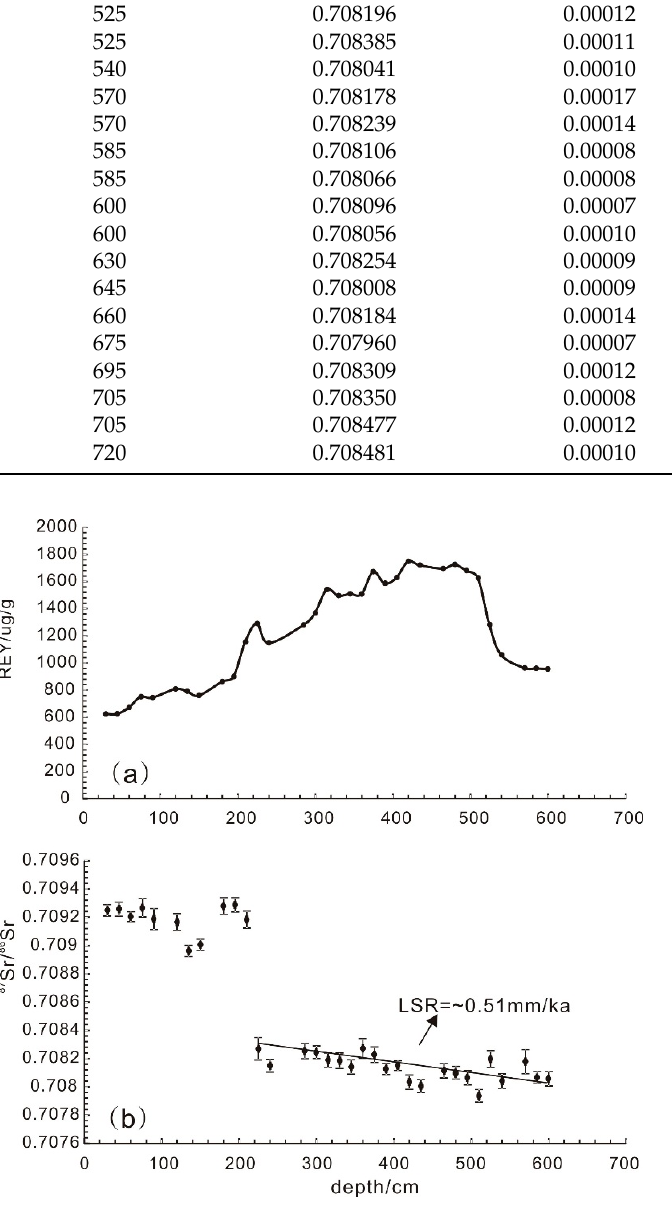
Figure 6. The REY content of sediment ( a ) and in situ fish teeth 87 Sr/ 86 Sr values ( b ) in core